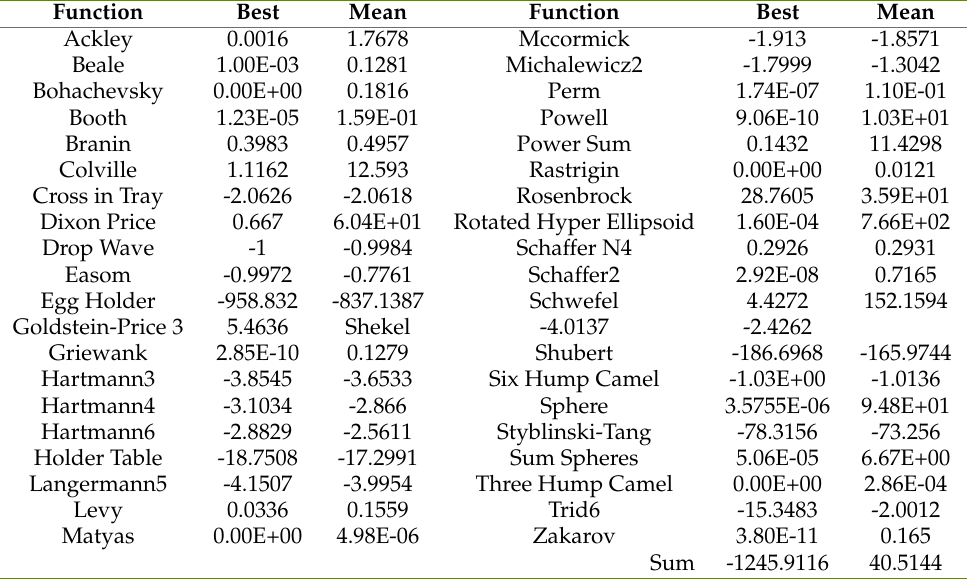
Table 7. Results of Cosine (AB) for a =